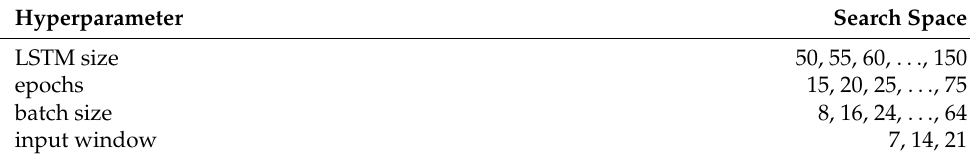
Table 1. Configuration Grid for Deep Learning Layer Hyperparameter Search